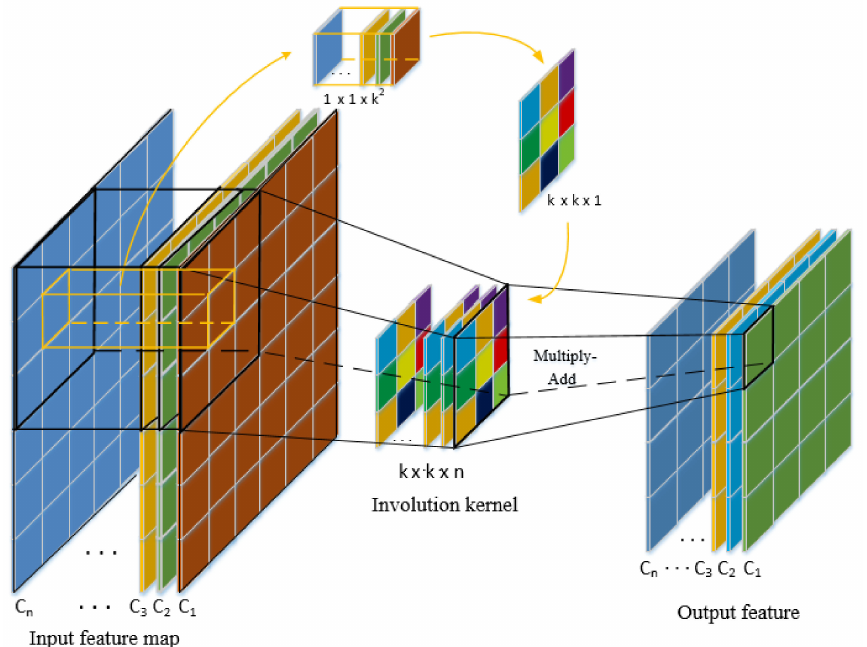
Figure 11. Schematic diagram of the involution (C is feature channel, k is involution kernel). 3.3.